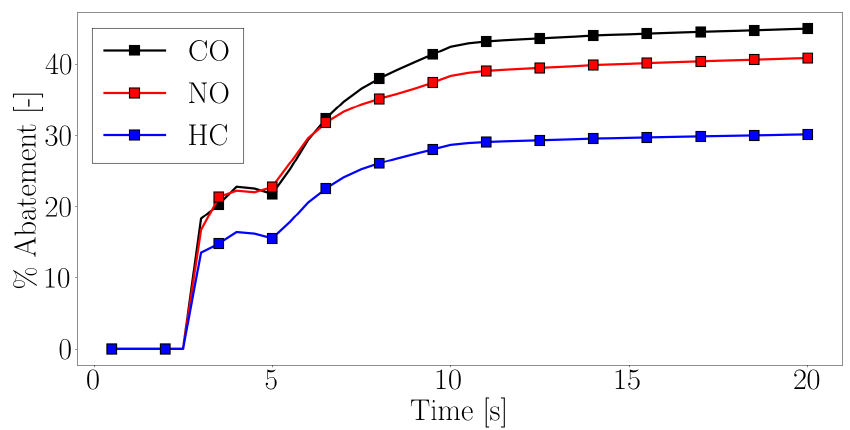
Figure 15. Pollutant abatement with the activation of the EHC–POCS